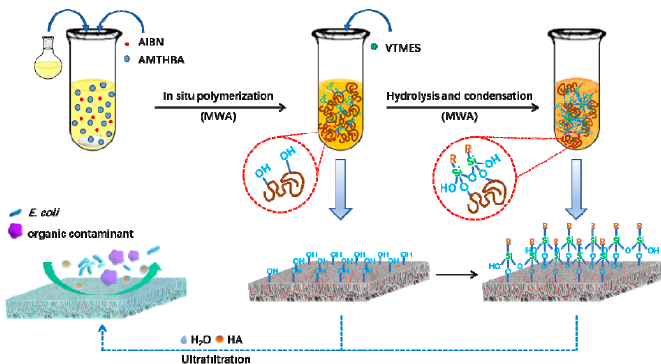
Figure 2. Schematic illustration for the fabrication of dual antifouling and antibacterial hybrid membranes. Table 1. Compositions of casting solutions used to prepare the modified membranes.